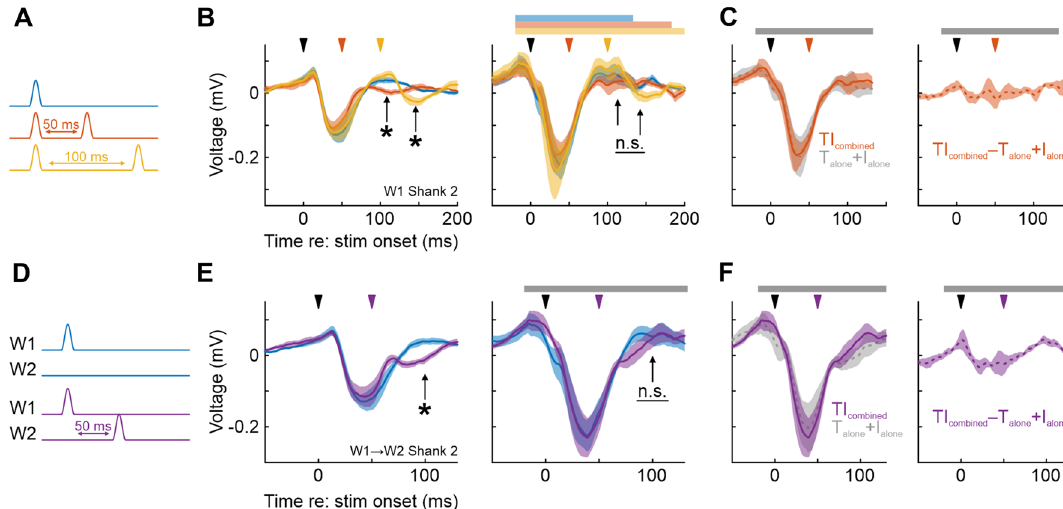
Figure 3. Optogenetic inhibition of PV+ interneurons increases LFP responses to multiple whisker deflections. ( A – C ) LFP responses to subsequent deflections of the same whisker after 50 ms or 100 ms. ( A ) Sketch of the stimulation protocol. ( B ) Left: Average LFP responses to the three stimuli illustrated in the sketch, without light application. Arrows indicate LFP components representing the 2nd stimulus pulse. Right: As in the left panel, but during light application. Horizontal bars indicate period of light application. ( C ) Left: For 50 ms interpulse- interval, summation of the two LFP responses from whisker deflection alone and light application alone (gray) and when recorded under both tactile and light stimulation (red, same as in panel B). Right: Differences between the traces shown in the left panel. ( D – F ) LFP responses to subsequent deflections of adjacent whiskers (W2 50 ms after W1). D) Sketch of the stimulation protocol. ( E ) Left: Average LFP responses to the two stimuli without light. Right: As in the left panel, but with light application. ( F ) Left: For 50 ms interpulse-interval, summation of the two LFP responses from whisker deflection alone and light application alone (gray) and when recorded under both tactile and light stimulation (lilac, same as in panel E). Right: Differences between the traces shown in the left